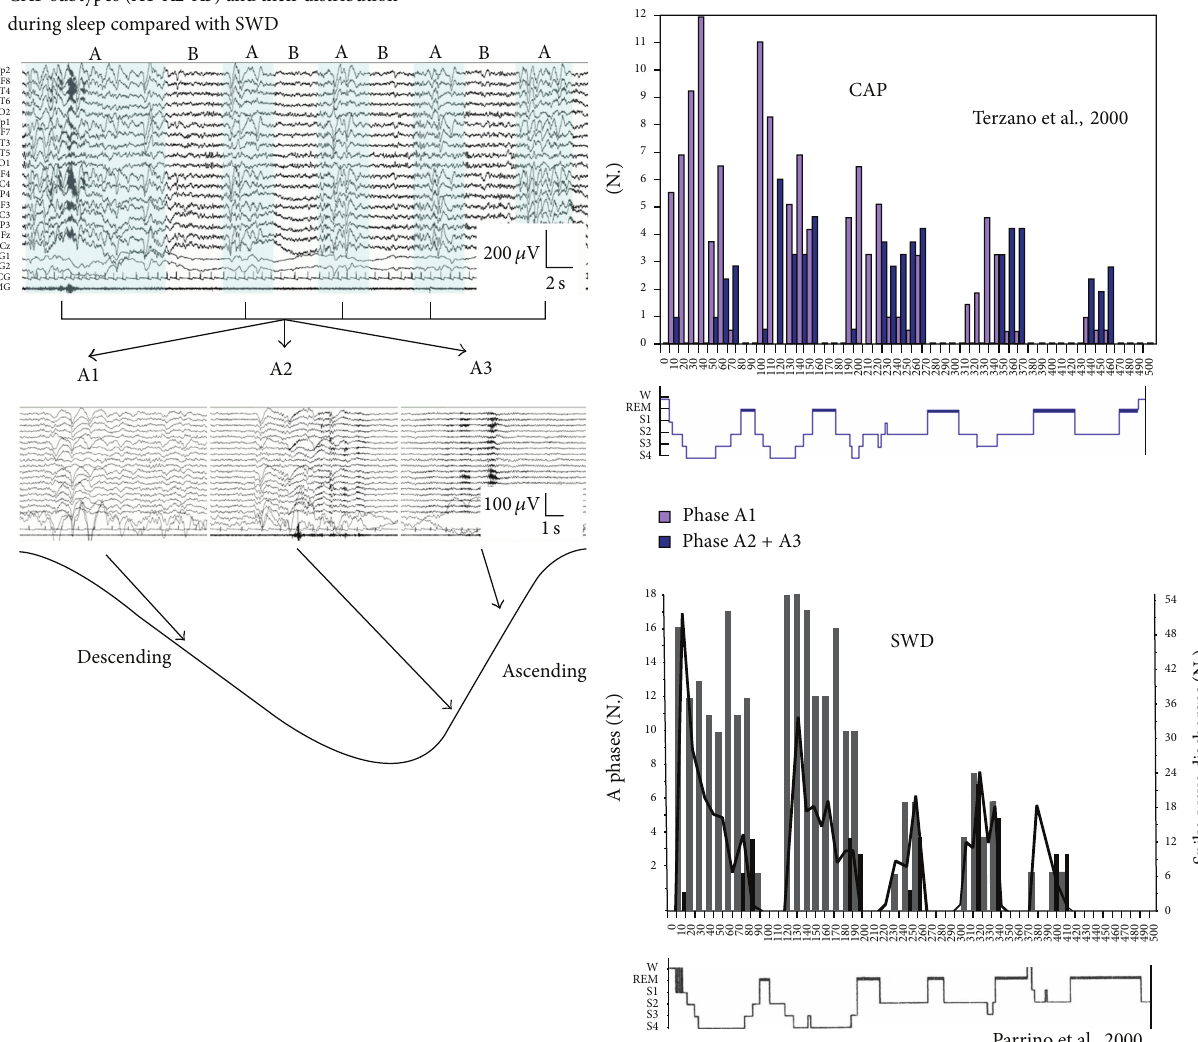
Figure 2: Distribution of CAP subtypes across a sleep cycle and the typical distribution of the subtypes from cycle to cycle, compared with the distribution of spike-wave discharges (after Terzano et al. [18] and Parrino et al. [19]).